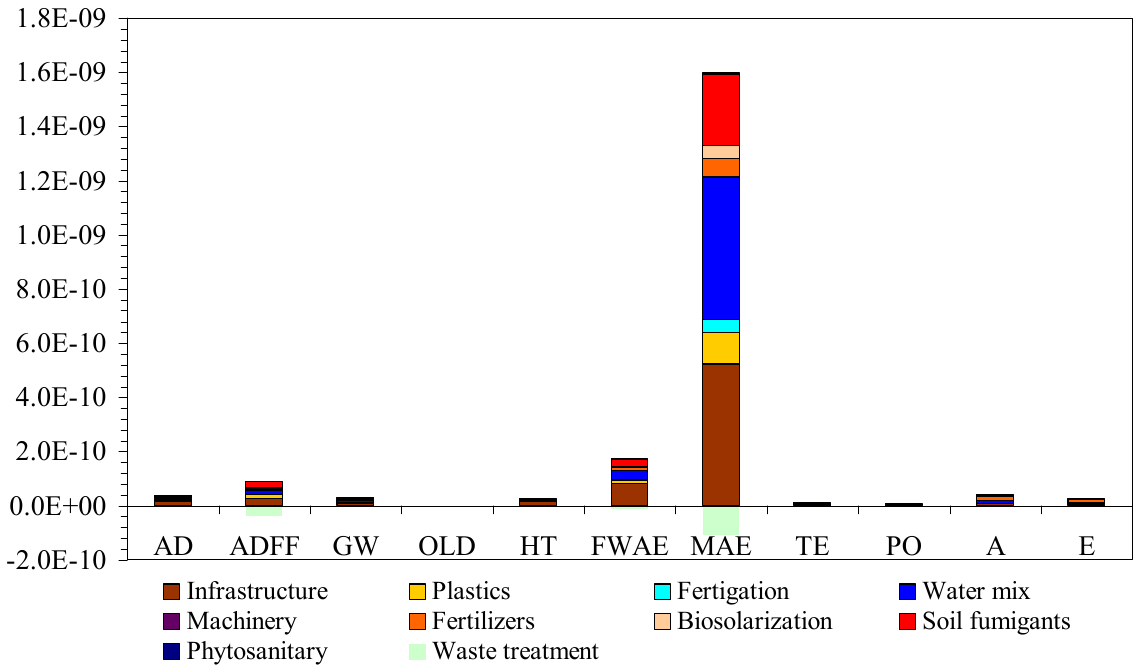
Figure 3. Normalization of the potential environmental impacts and the contributions of the compo- nents of the system.